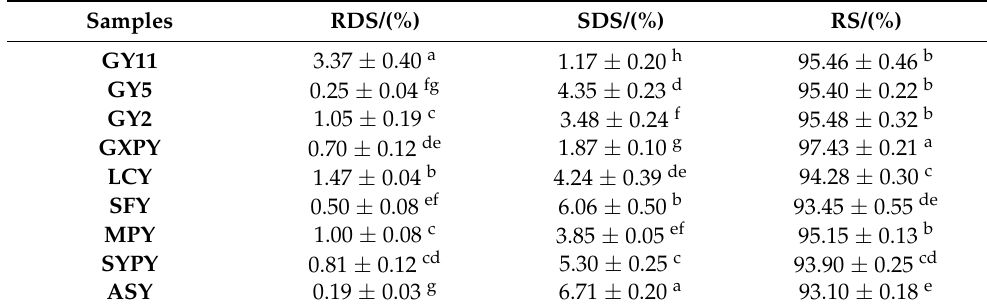
Table 4. The in vitro starch digestion of yam